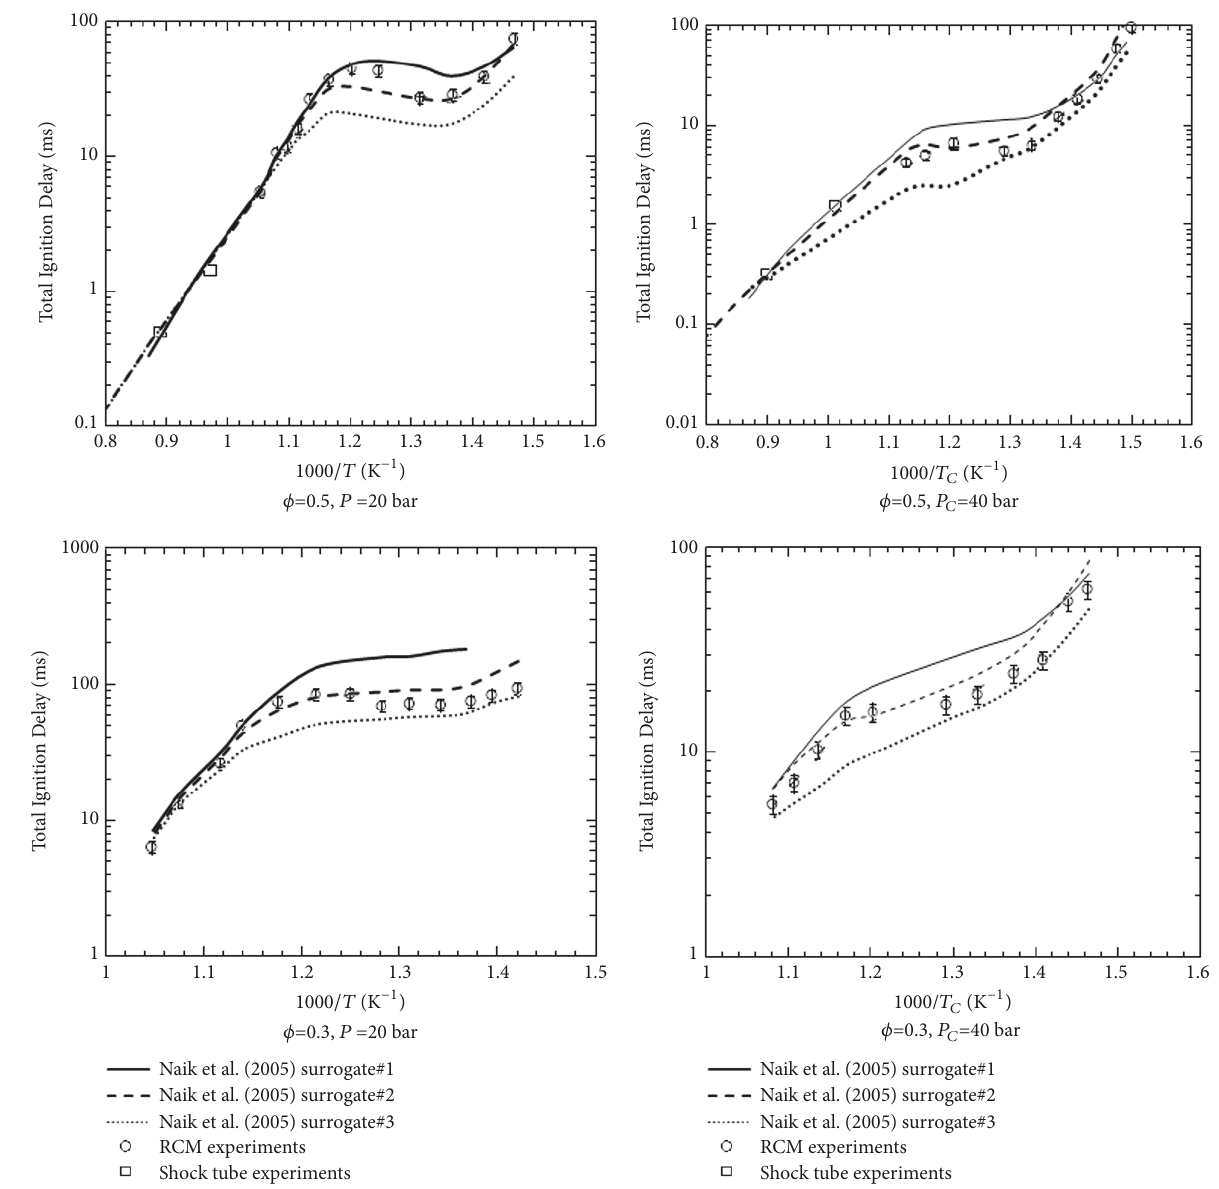
Figure 15: Comparison of RD387 experimental and simulated surrogate total ignition delay times. Experimental data is from Kukkadapu et al. [23] and Gauthier et al. [10]. Surrogate simulations were carried out using Naik et al. [33] surrogates using the mechanism of Samimi Abianeh et al. [19]. Measured shock tube data are shown using ◻ at two approximate temperatures of 1000 K and 1100 K.